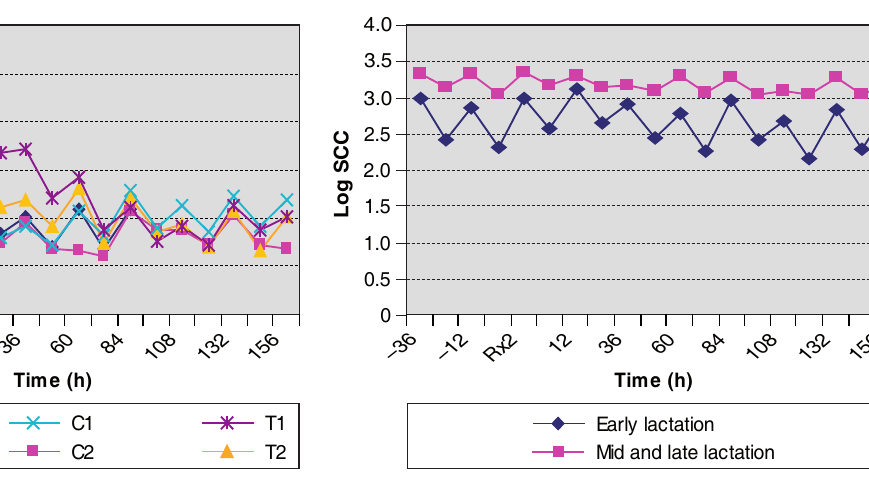
FIG.2 Mean log SCC of milk goats in early lactation versus goats in mid and late